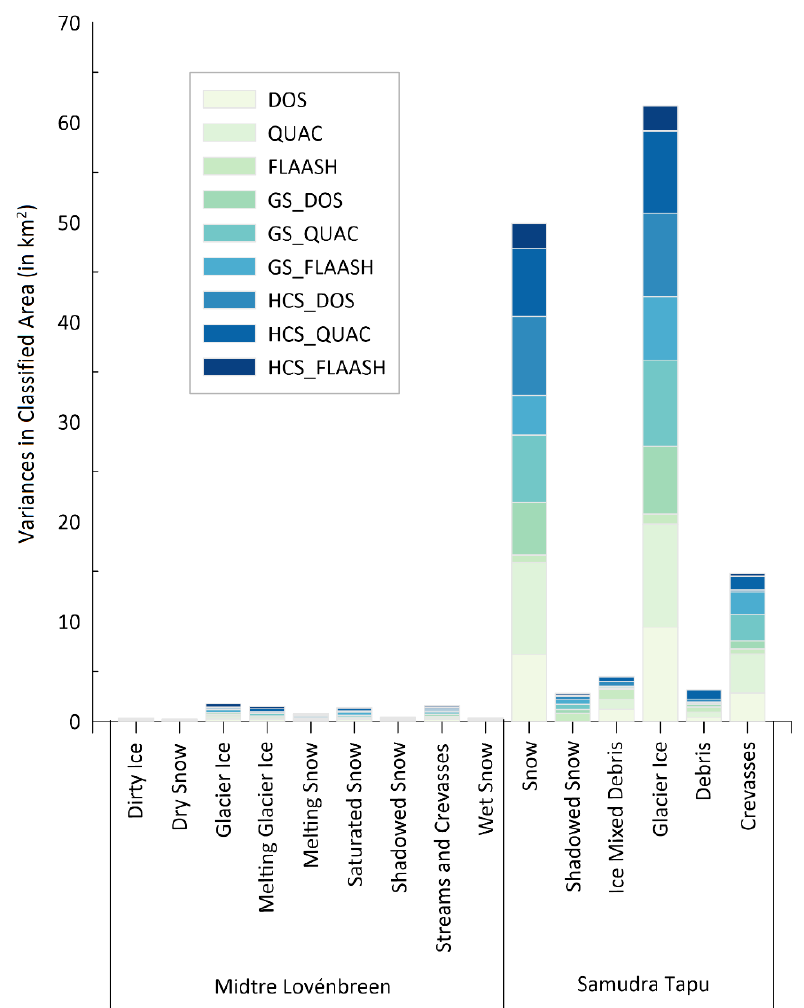
Figure 6. Variations in classified area of each facies for the representative glaciers ML and ST. Stacked columns highlight variances in the classified area between processing schemes for the same facies.